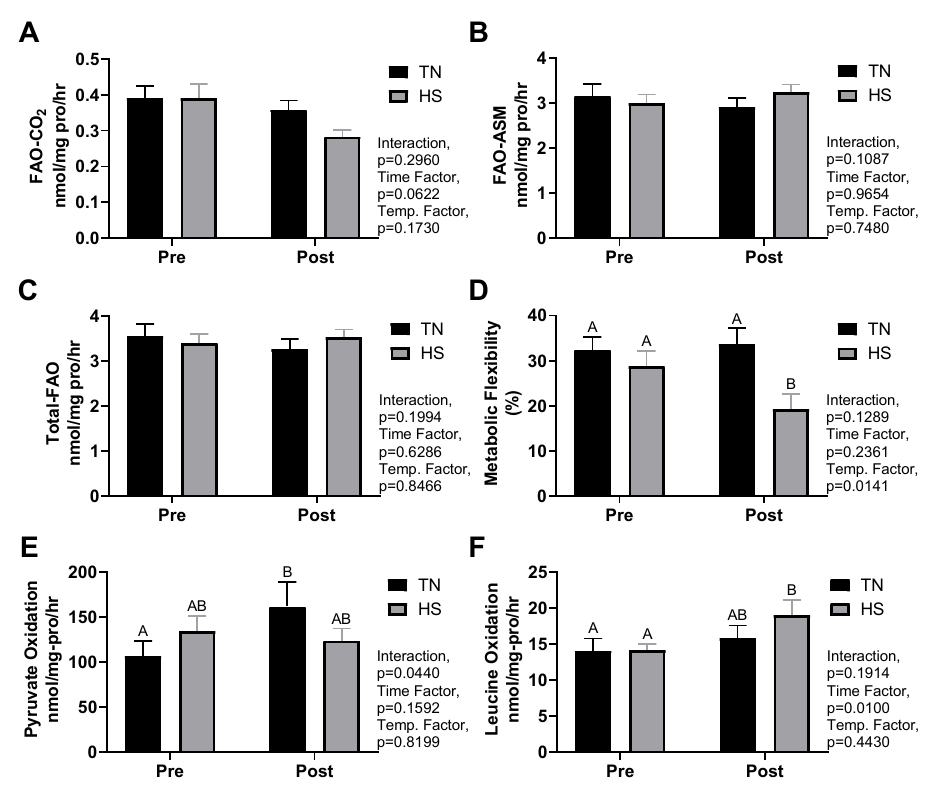
Figure 2. Effect of environmental conditions on growing pigs for measures of complete fatty acid oxidation (FAO-CO 2 ) ( A ), acid soluble metabolites (incomplete oxidation) (FAO-ASM) ( B ), total-FAO (FAO-CO 2 + FAO-ASM) ( C ), metabolic flexibility (pyruvate oxidation:pyruvate oxidation +100 µ M palmitic acid) ( D ), pyruvate oxidation ( E ), and leucine oxidation ( F ). Pigs were acclimated under thermoneutral conditions (14 h light/10 h dark, 21.6 ± 0.8 ◦ C, with humidity 46–64%) for five days prior to treatment (Pre). Pigs were then randomly assigned ( n = 8 per group) to thermal neutral (TN, 22.0 ± 0.4 ◦ C, with humidity 43–63%) or heat stress (HS, 33.6 ± 0.5 ◦ C, with humidity 22–40%) treatment groups for five days (Post). Means without a shared letter are significantly different, p <